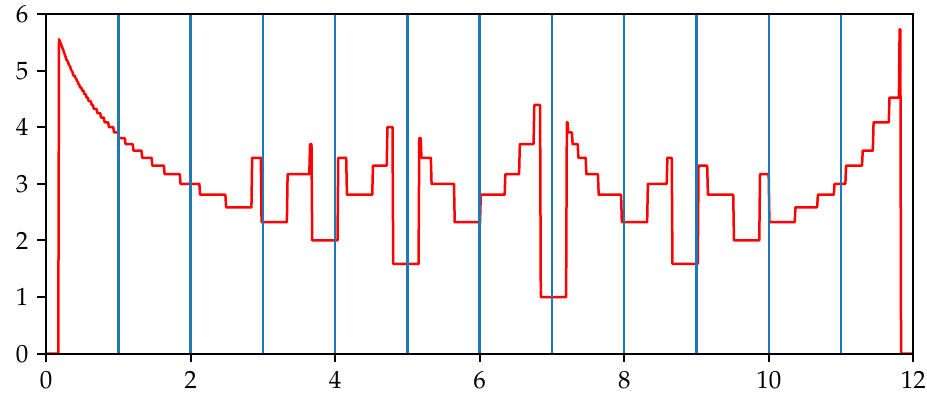
Figure 6. Logarithmic periodicities of dyads spanning at most one octave.